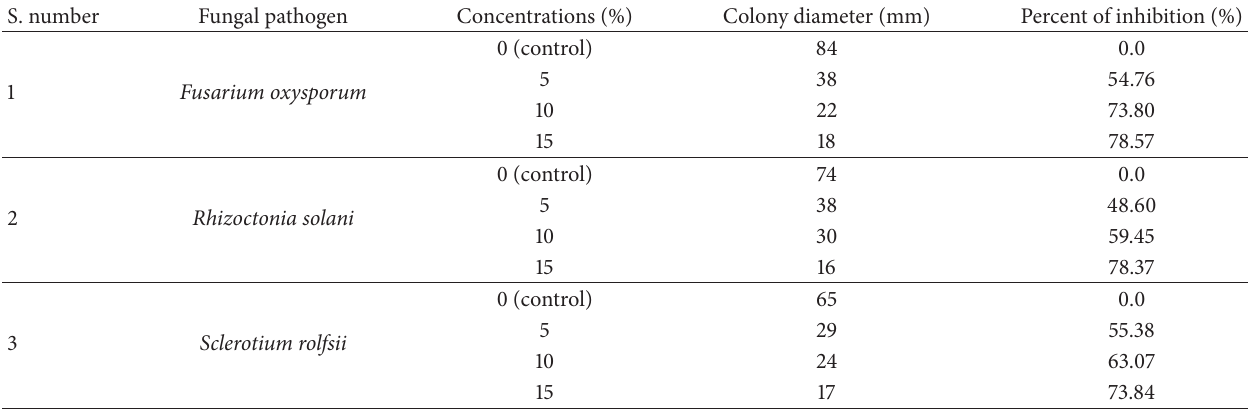
Table 1: Antifungal activity of cow urine by poison food